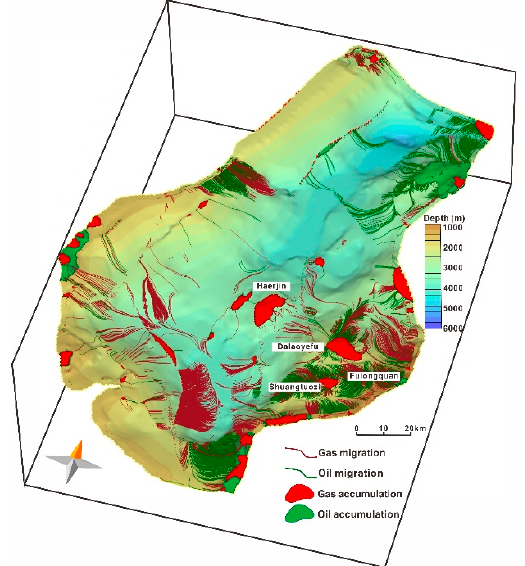
Figure 16. Current hydrocarbon-migration paths and accumulation zones in K 1 d.